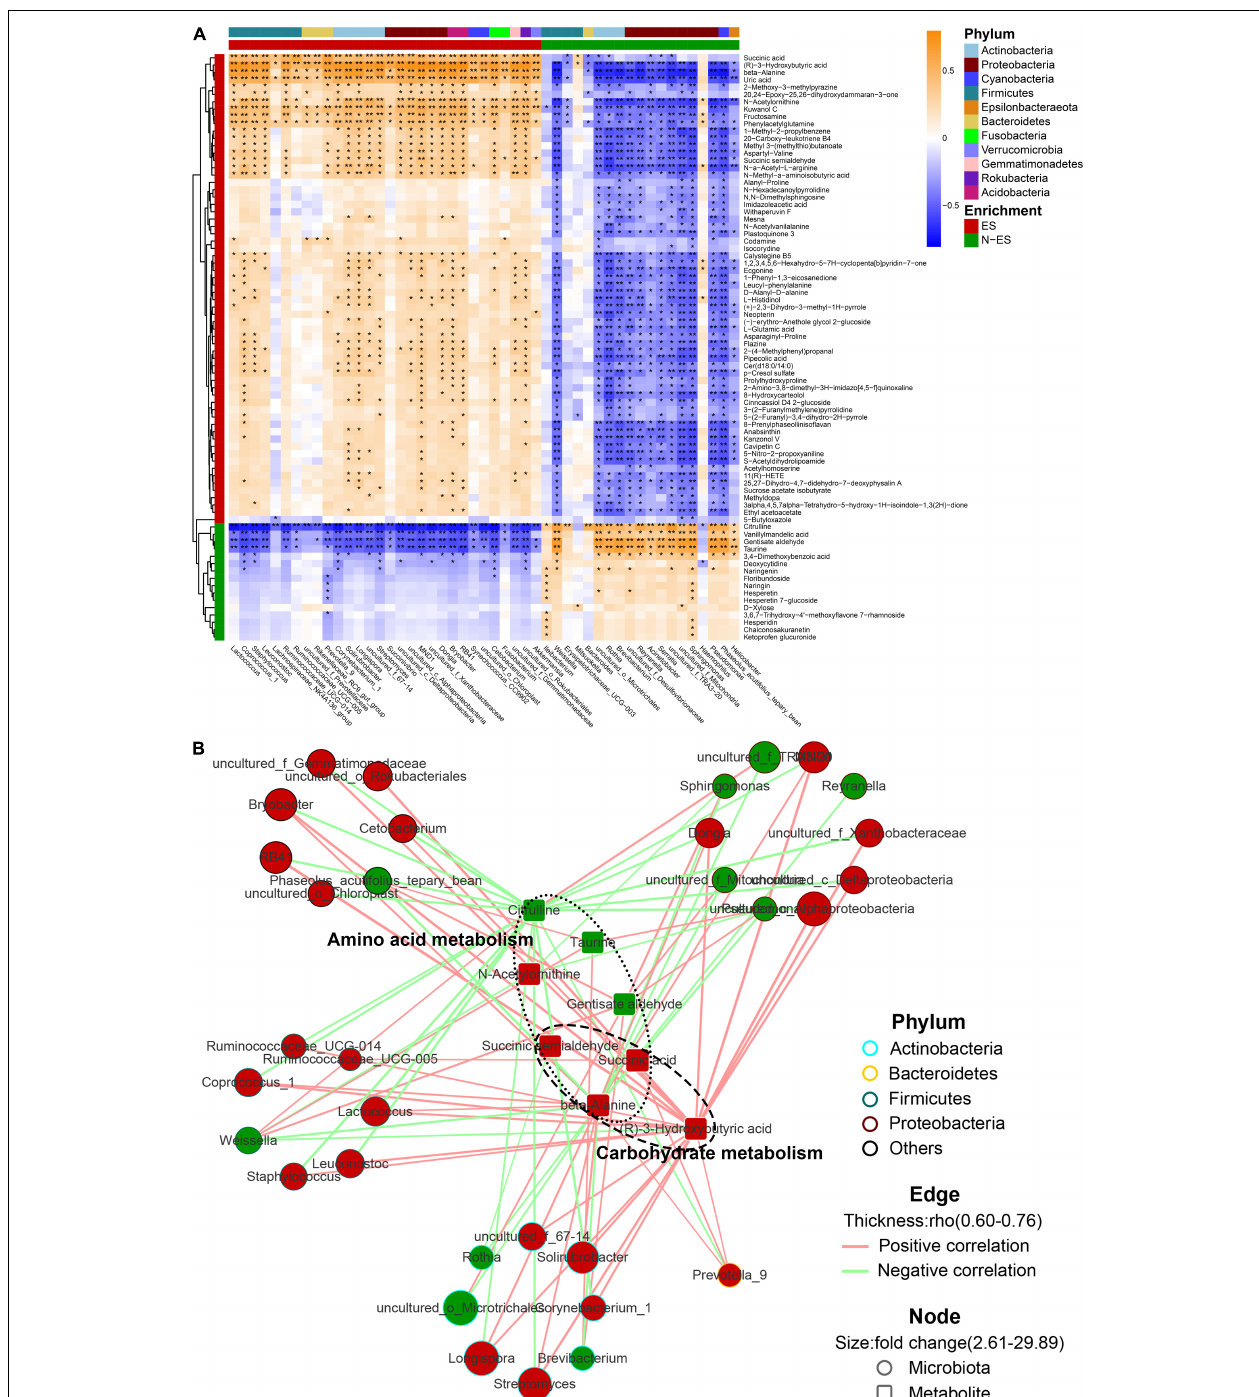
FIGURE 5 | The multi-omics correlation analysis of the microbiome and metabolome. (A) Correlations between dominant genera ( > 0.05%) and metabolites with > 2.5-fold changes between ES and N-ES, VIP > 1, and P < 0.05 (Student’s t -test). Enrichment in either group and higher levels of taxonomy (phylum) are indicated by colored bars at the left and top of the heatmap. Significant correlations are denoted by black stars (* P < 0.05, ** P < 0.001, Student’s t -test with false discovery rate adjustment for multiple comparisons). (B) Network profiles of the correlations with absolute coefficients higher than 0.6. The node shape represents the components involved in this study (circle: microbiota; round rectangle: metabolite). In the network, these metabolites mainly belong to carbohydrate and amino acid metabolism. The colors of the border of circles indicate different phyla. The node size indicates the fold change, and the color reflects higher abundance in either ES (red) or N-ES (green) samples. Edges between nodes stands for Spearman’s positive (light red) or negative (light green) correlation; the edge thickness denotes the range of the absolute coefficients.